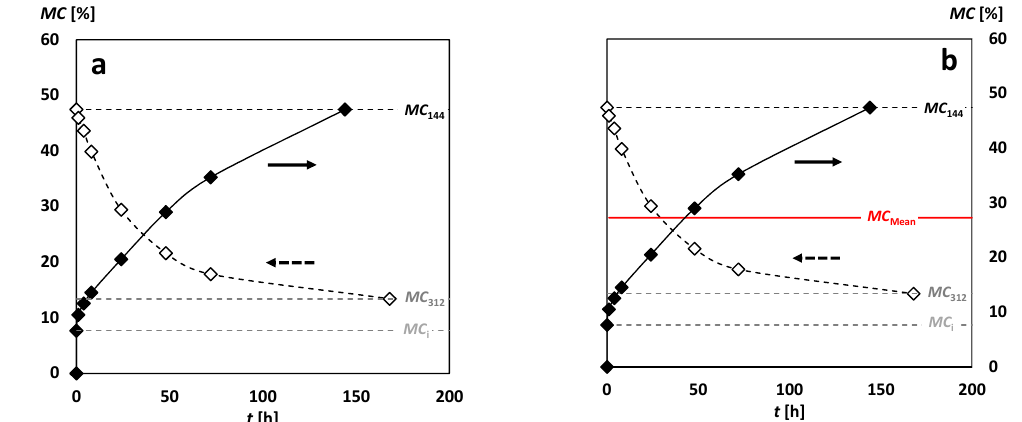
Figure 10. Moisture content ( MC ) development during 144 h water uptake and 168 h desorption determined in a submersion test, the initial MC ( MC i ), the MC after 144 h of water uptake ( MC 144 ), the MC after 168 h of desorption ( MC 312 ) of Norway spruce (150 (ax.) × 50 × 25 mm 3 , ( a ) and the resulting mean MC ( MC mean ) calculated according to Equation (12) ( b ).